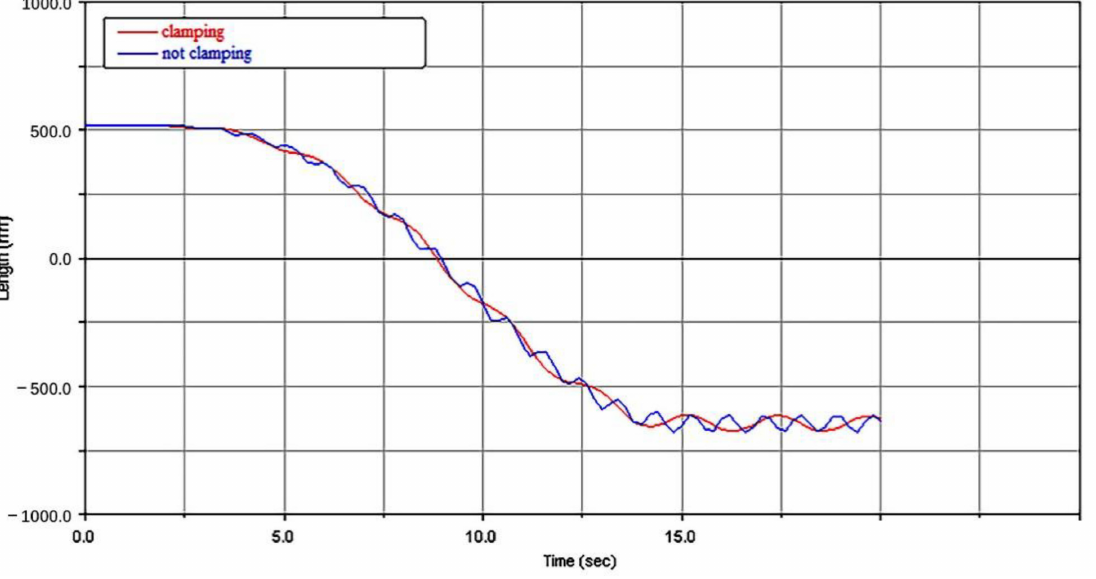
Figure 17. Displacement distribution with and without clamped